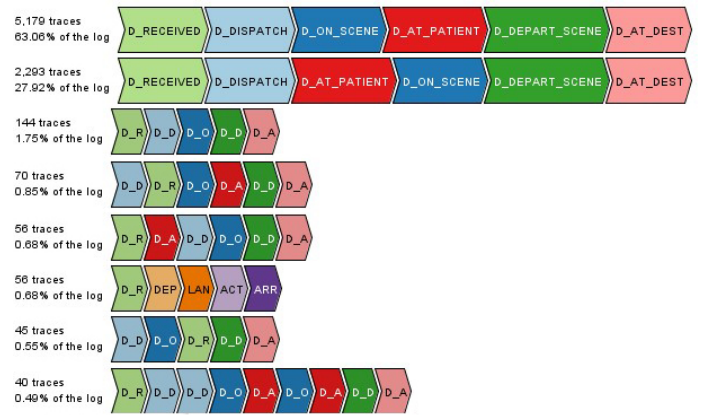
Figure 7. Cohort 2—most frequent trace